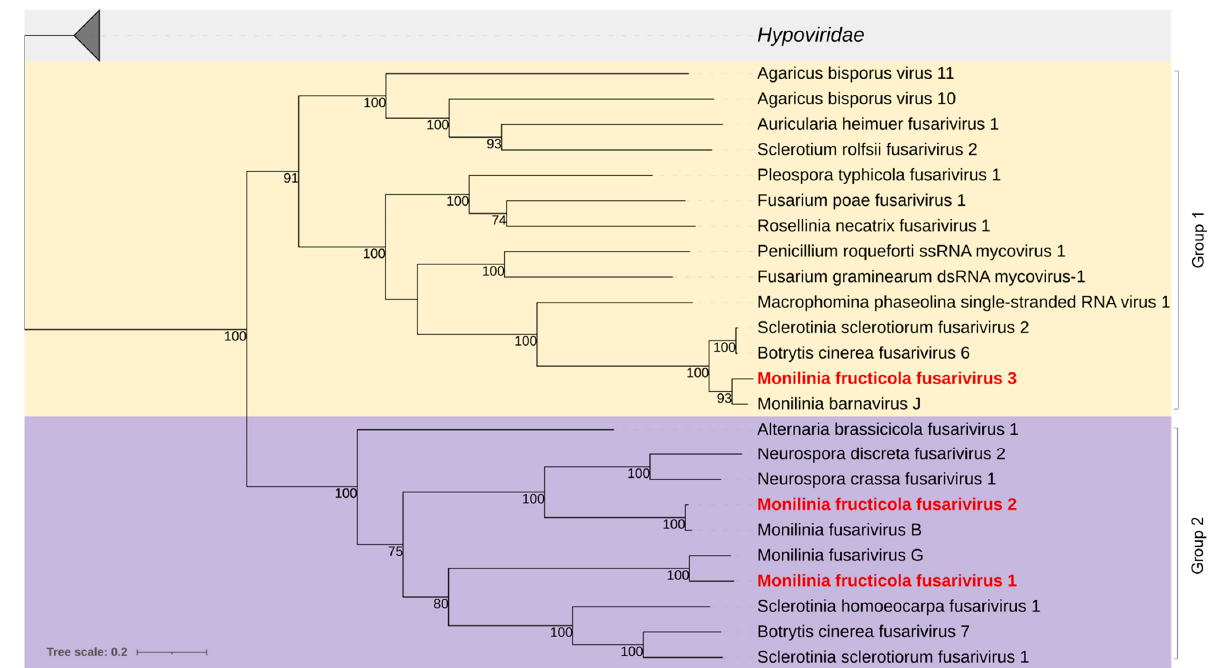
Figure 4. Maximum likelihood phylogenetic tree based on multiple amino acid sequence alignment of the RdRp proteins of viruses in the proposed Fusariviridae family and its relationship with the closely related family Hypoviridae . Coloured boxes indicate Group 1 (yellow) and Group 2 (purple) of the fusariviruses [44]. Mycoviruses found in this work are in bold red. The numbers on nodes, shown for values greater than 50%, are the results of 1000 bootstrap analyses. The scale bar represents a genetic distance of 0.2 amino acid substitutions per site. The list of accession numbers of the analysed sequences is in Table S1.